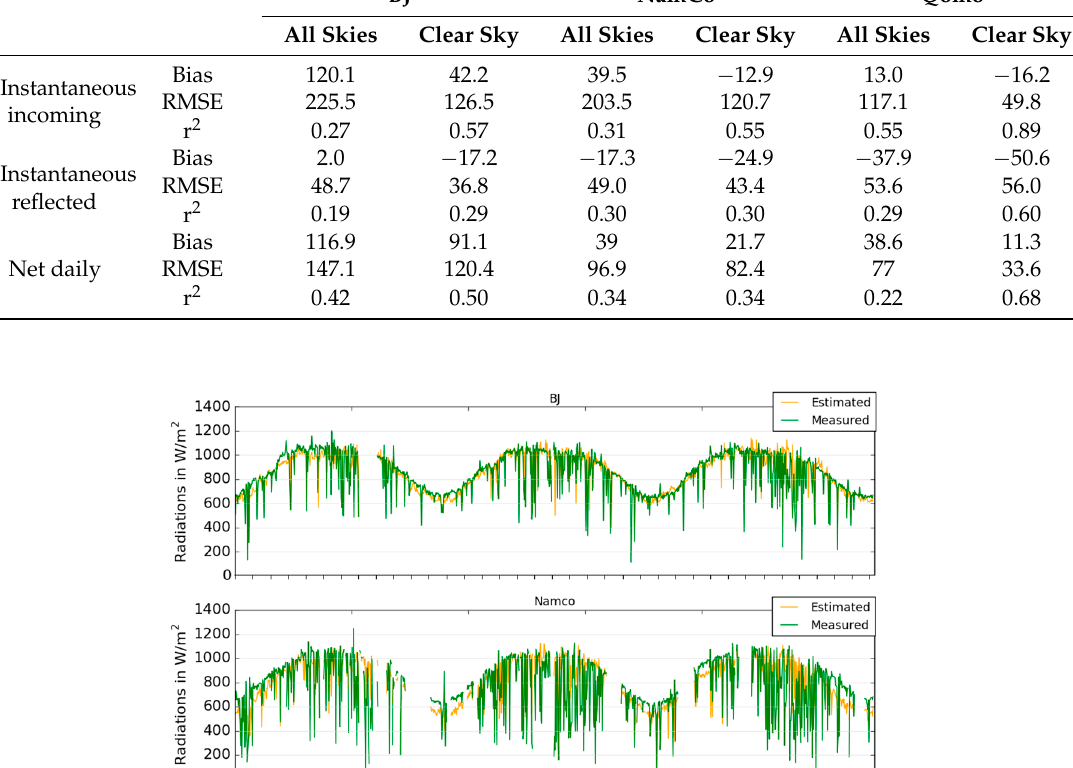
With Topographic Without Topographic Correction Correction All Skies Clear Sky